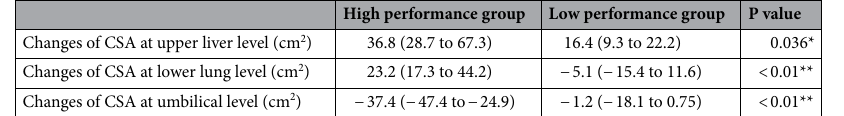
Table 3. Changes in CSA from resting to streamlined body position at three levels between two group. All data are presented as medians with interquartile ranges. CSA cross-sectional area. *p < 0.05, **p < 0.01.